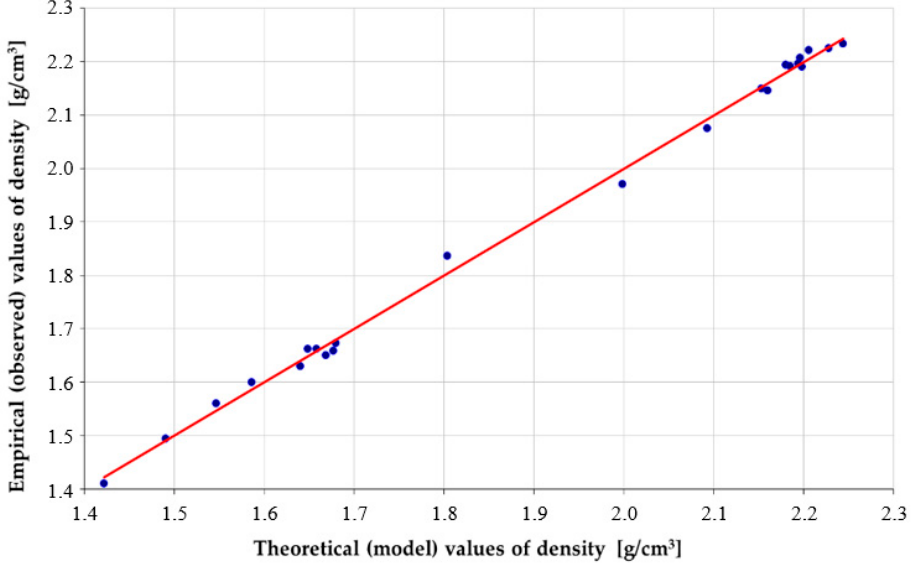
Figure 7. The empirical values compared to the theoretical ones obtained from the model (16).